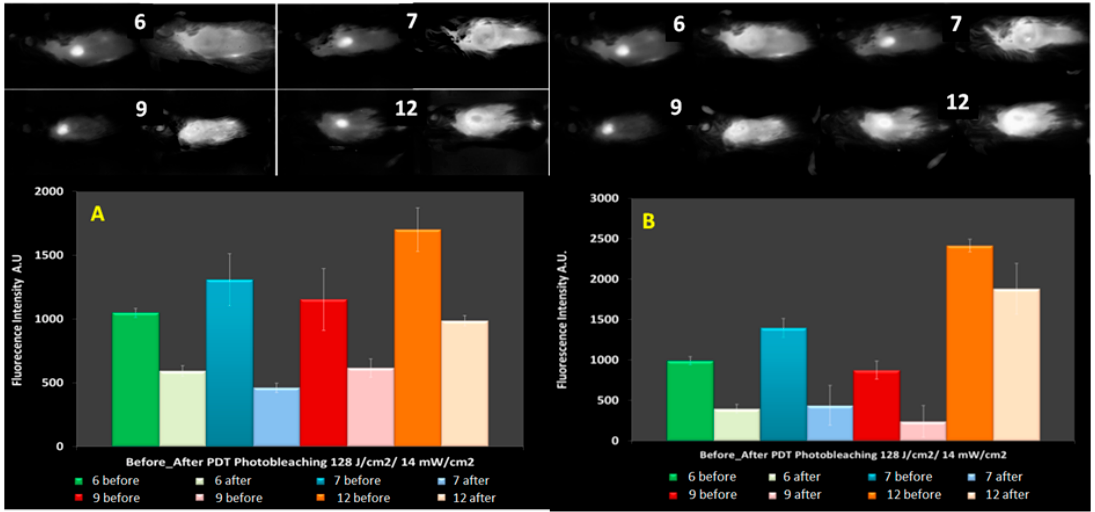
Figure 6 . ( A ) Photobleaching of the HPPH portion of PS-CD conjugates and ( B ) a comparative